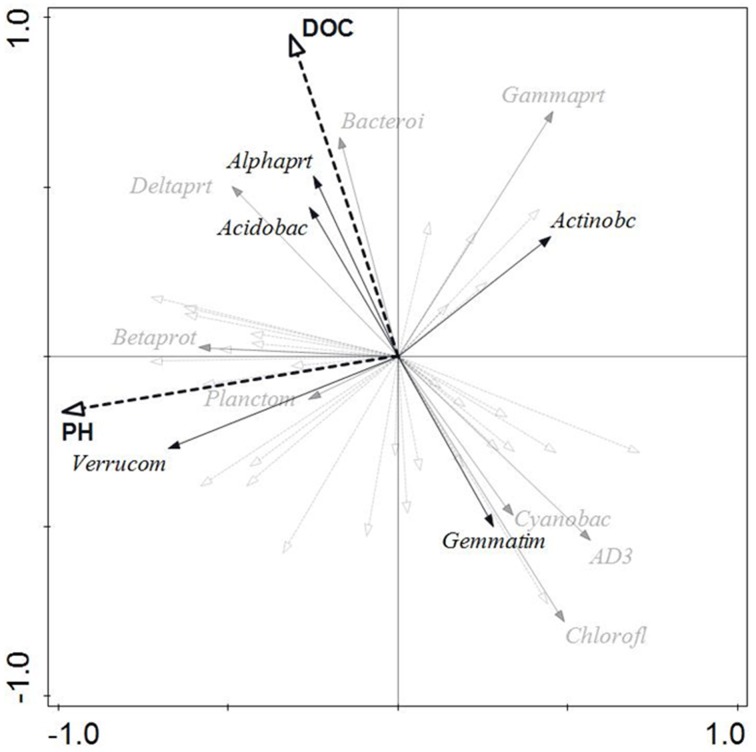
Redundancy analysis biplot for bacterial phyla and proteobacterial classes at the DNA level in the 12 soil cores. Dashed black arrows represent soil parameters with a significant (P < 0.05) influence on bacterial community structure. Solid black arrows represent dominant (>5% of the community) bacterial phyla and proteobacterial classes, while solid, gray arrows and hatched, gray arrows represent bacterial phyla and proteobacterial classes with a relative average abundance of 1–5% or <1%, respectively.